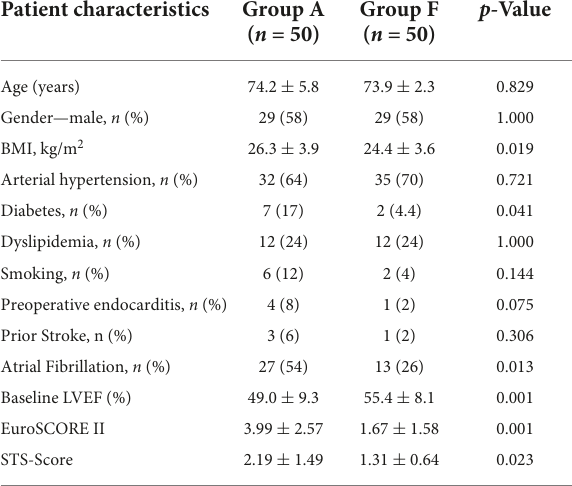
TABLE 1 Preoperative patient characteristics: Antegrade axillary perfusion (group A) vs. retrograde femoral perfusion (group F). Patient characteristics